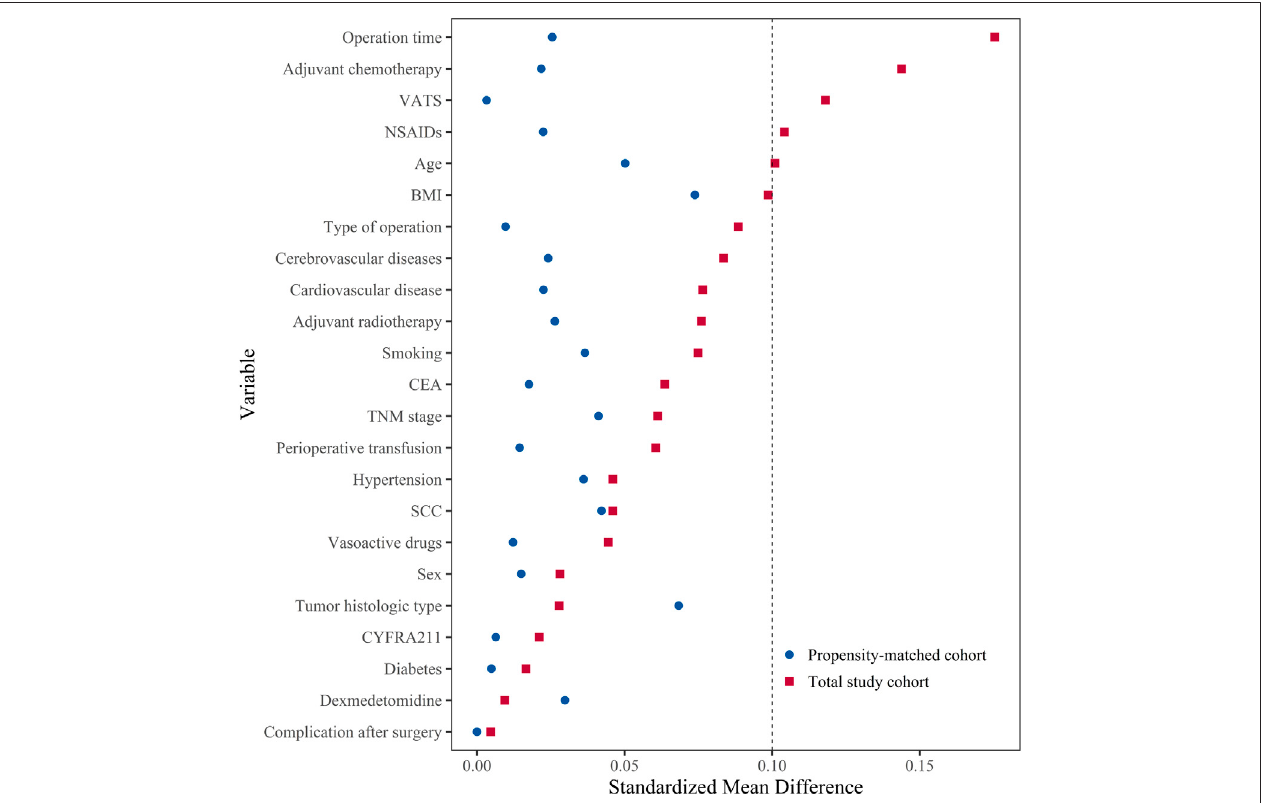
FIGURE 2 | The distribution of standardized mean difference for variables included before and after matching. Standardized mean difference values < 0.10 presented that the variable was well-matched and there was no difference between two groups. BMI, body mass index; CEA, carcinoembryonic antigen; CYFRA211, cytokeratin-19 fragment 21-1; NSAIDs, non-steroidal anti-in fl ammatory drugs; SCC, squamous cell carcinoma antigen; TNM, tumor-node-metastasis; VATS: video-assisted thoracic surgery.